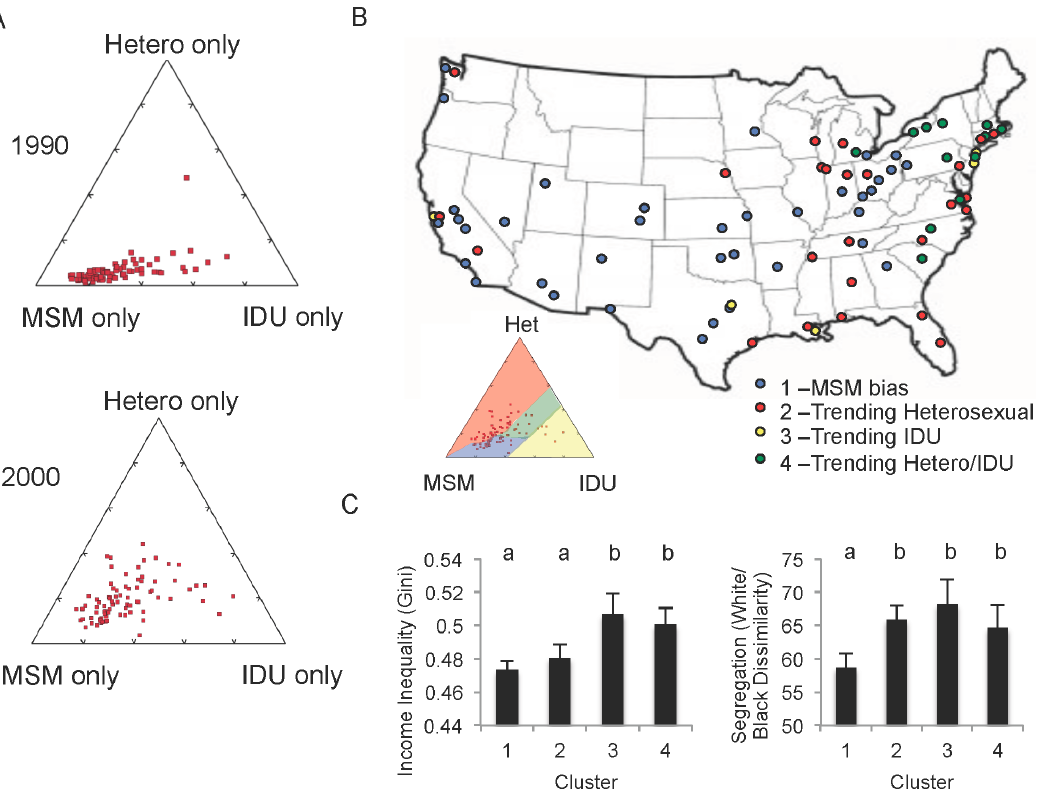
Figure 3. Proportion of HIV reports in each city with exposure risk of male-male sexual contact (MSM), heterosexual contact (Het.) or IV drug use (IDU). (Multiple or unknown exposure categories excluded.) A. Principle component analysis for HIV cases 1988–1992 (top) and 1998–2002 (bottom) shows an overall national trend away from MSM and toward heterosexual and/or IDU exposures. B. Cities clustered based on exposure trends. MSM-biased cluster (blue) is approximately delimited by the 1990 MSM region of the PCA plot. C. Average socioeconomic metrics were sorted with exposure clusters. More segregated cities (measured by white/black dissimilarity index) were significantly more likely to experience a higher proportion of non-MSM HIV cases. Cities with high income inequality were more likely to report a higher proportion of IDU-associated HIV. Lowercase letters represent statistical similarity (by T-test, p , 0.05).